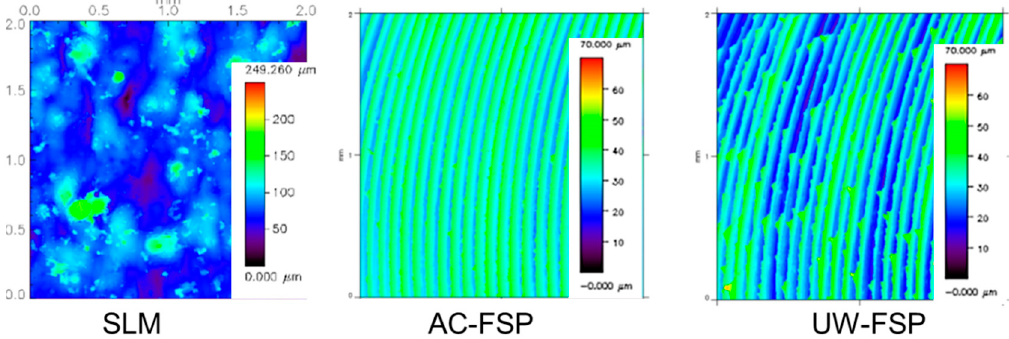
Figure 4. Surface topography obtained by optical measurements on the surface of samples in di ff erent conditions.